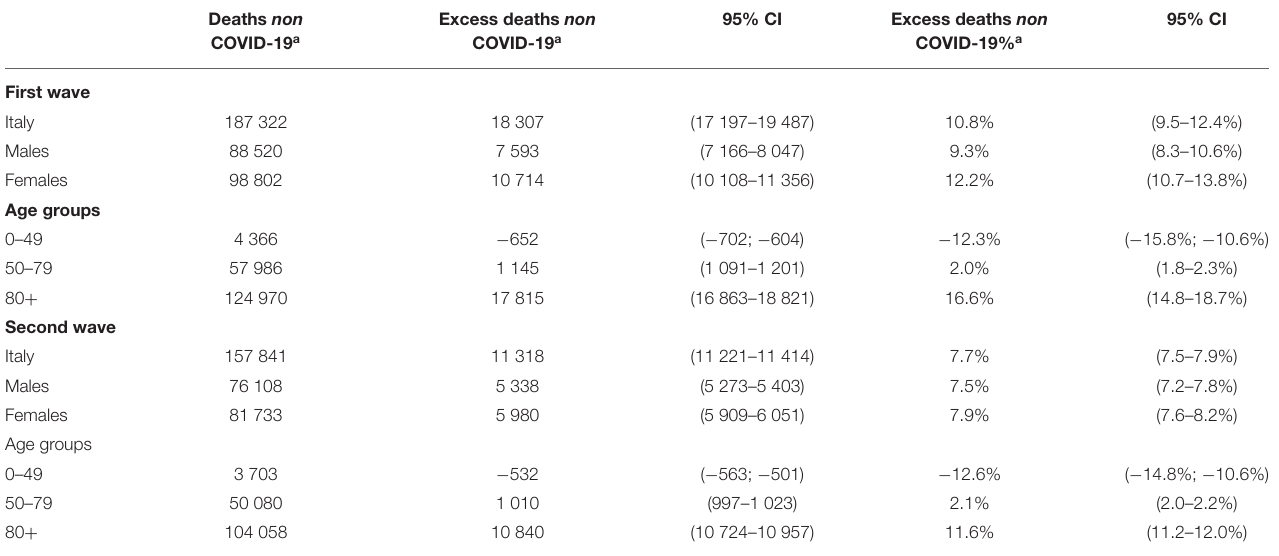
TABLE 3 | Estimates of excess deaths “not directly attributable to